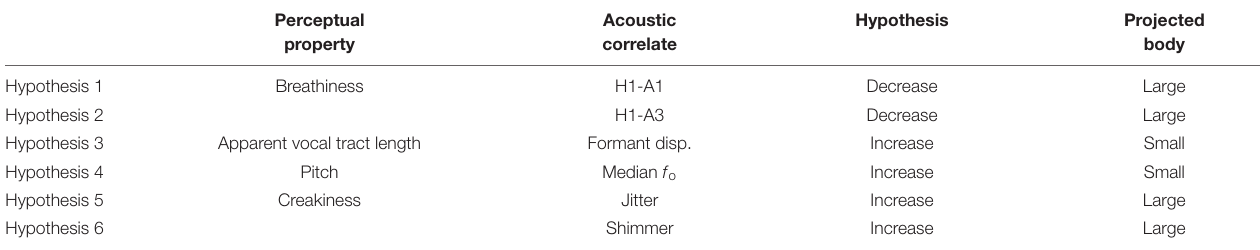
TABLE 1 | Working hypotheses (prediction for the attractive facial stimulus